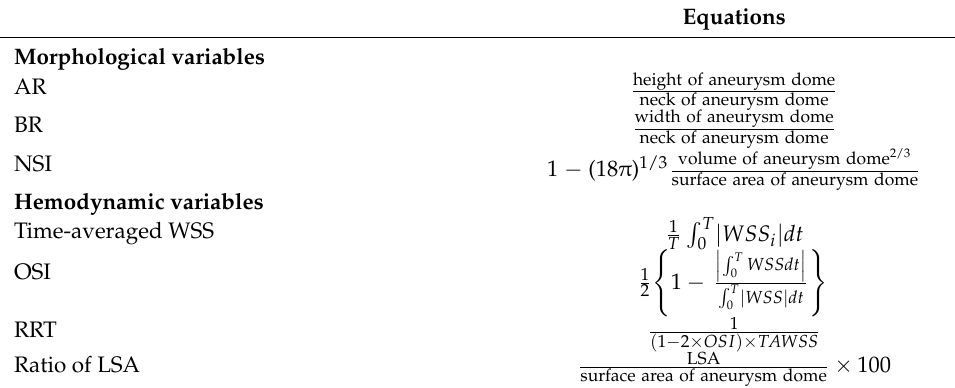
Table 1. List of equations used for evaluation of morphologic and hemodynamic variables.